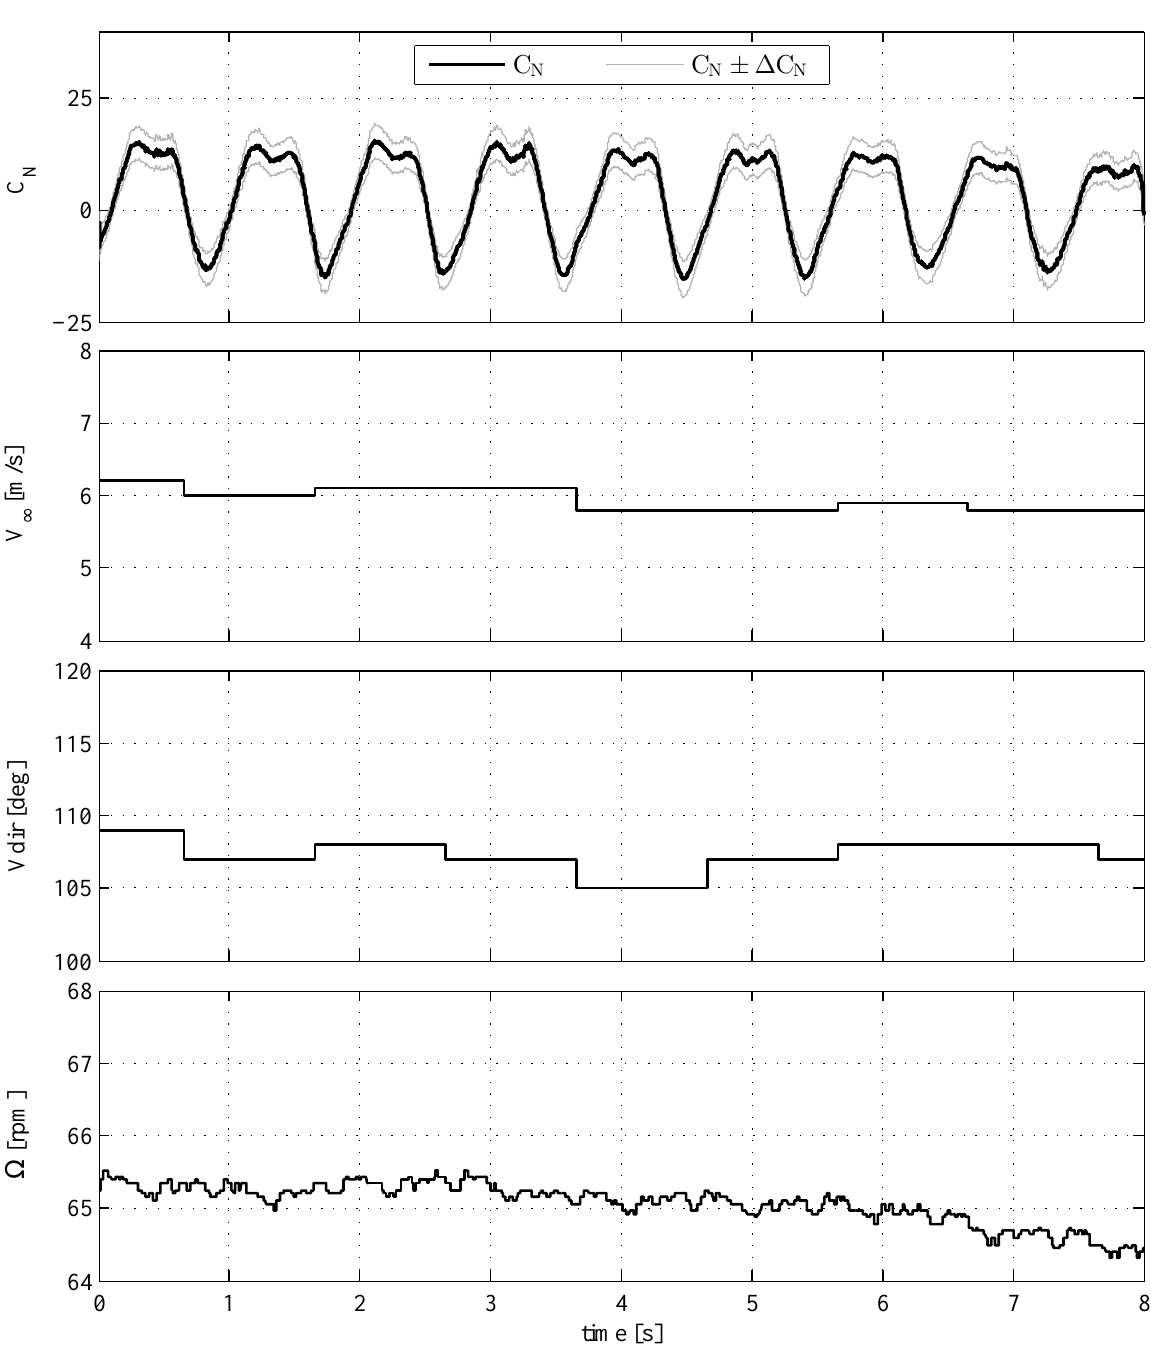
Figure 6. Normal force coefficient, wind speed, wind direction and the turbine rotational speed at steady wind conditions, λ = 3.7, (cid:104) Ω (cid:105) = 65